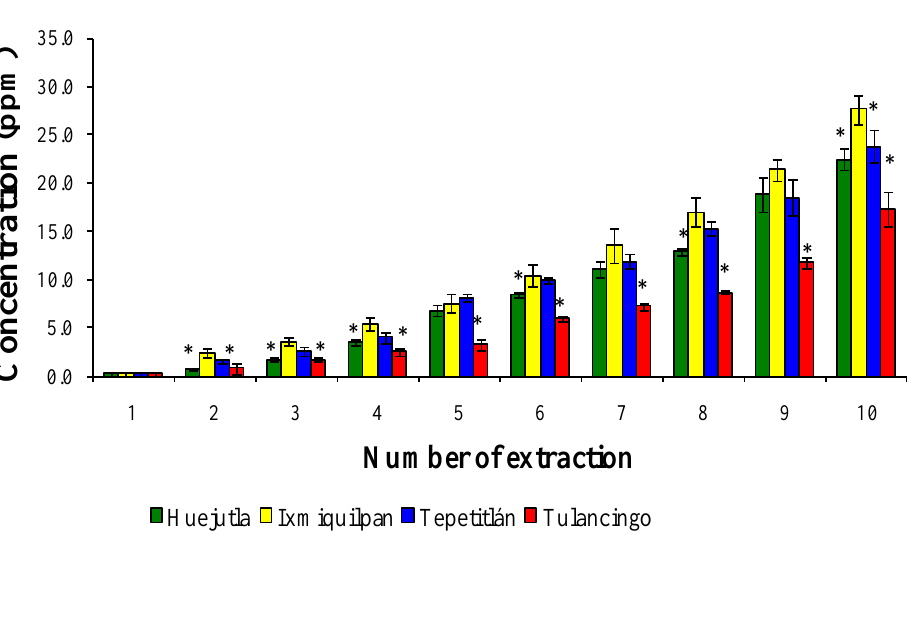
Figure 2. Concentration of Co leached from the glass-clay containers into the green tomato sauce (salsa). The bars show the mean values of the four regions studied along with their standard deviations. * Indicates significant statistical differences with respect to the Ixmiquilpan region, which represents the highest concentration of the metal; p ≤